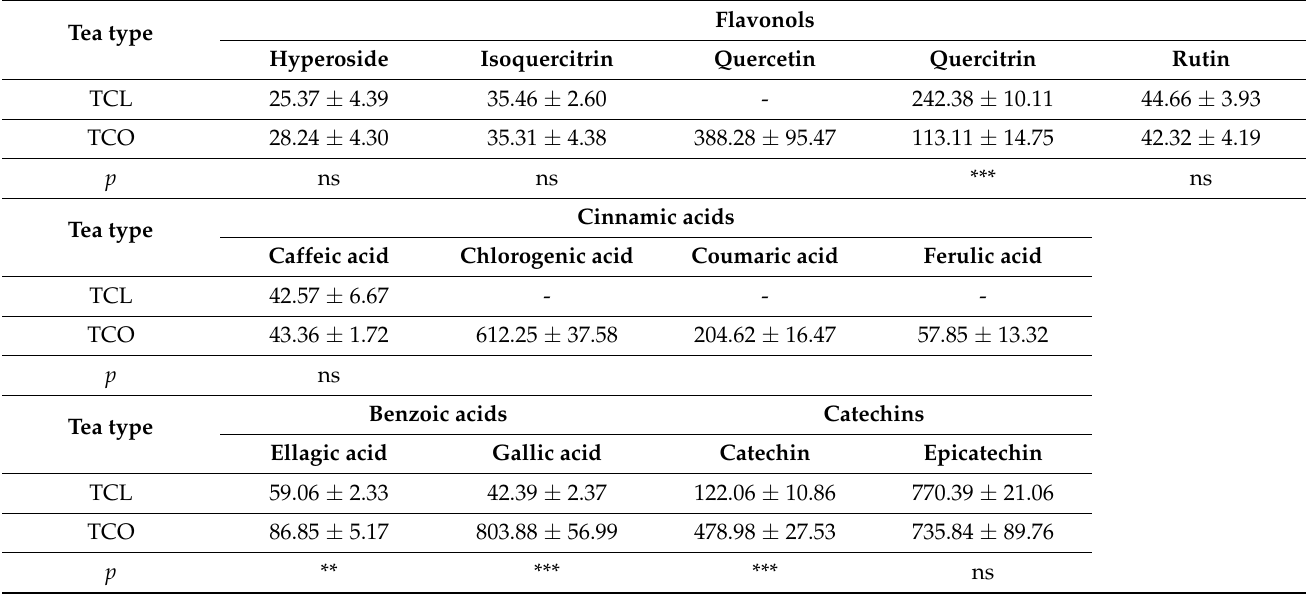
Figure 2. Chromatographic profile of benzoic acids and catechins ( A ), and cinnamic acids and flavonols ( C ) in TCO. Chromatographic profile of benzoic acids and catechins ( B ) and cinnamic acids and flavonols ( D ) in TCL. TCO = Tea Camellia d’Oro. TCL = Tea Compagnia del Lago. Table 3. Bioactive compounds in Tea Compagnia del Lago (TCL) and Tea Camellia d’Oro (TCO). Data are presented as mean value ± standard deviation. The values are given in mg 100 g −1 DW.